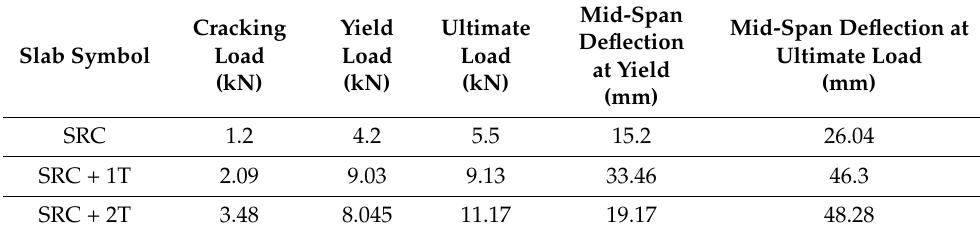
Table 7. The test results of the three tested